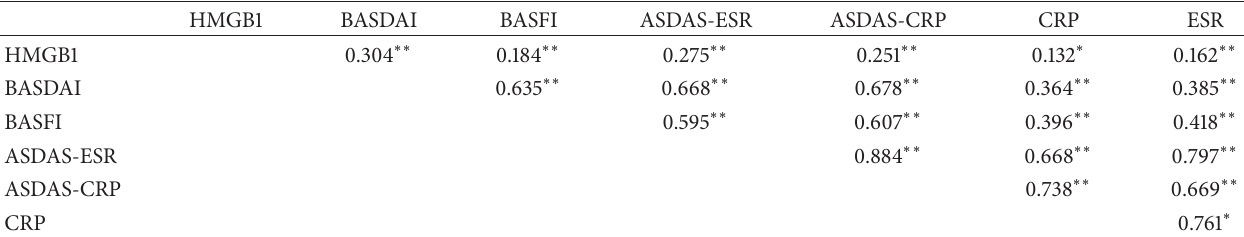
Table 2: Spearman’s correlation analysis between serum HMGB1 and clinical parameters of the 147 AS patients, including the baseline and the follow-up time points.